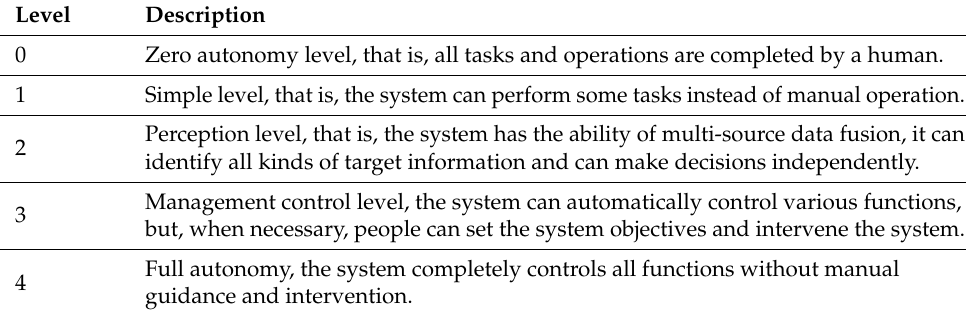
Table 2. Autonomy level of military combat